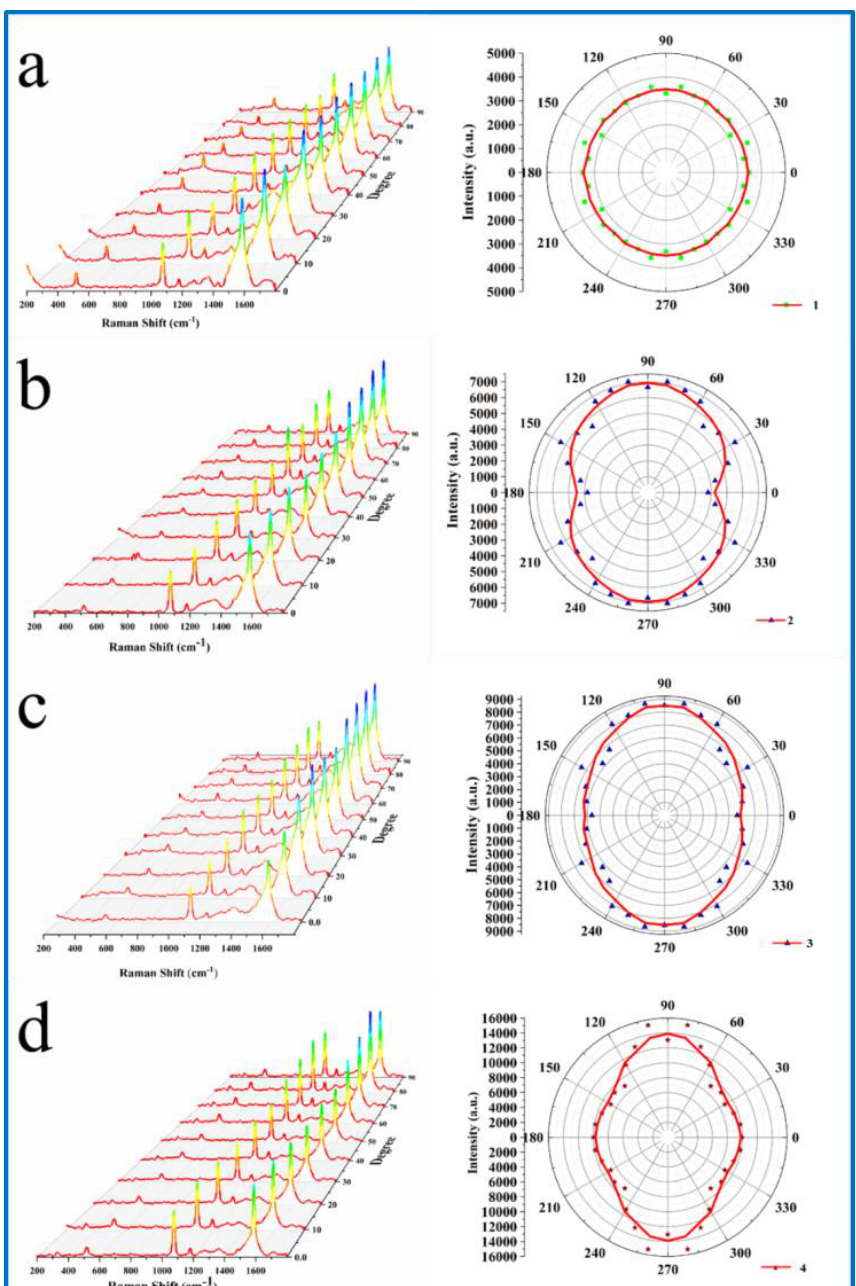
Figure 3. The left figure ( a – d ) is the spectrum diagram of SERS of 4-MBA adsorbed on samples of different shapes changing with the angle of excitation light, and the right figure is the polar coordinate diagram of corresponding SERS strength changing with the angle of incident excitation